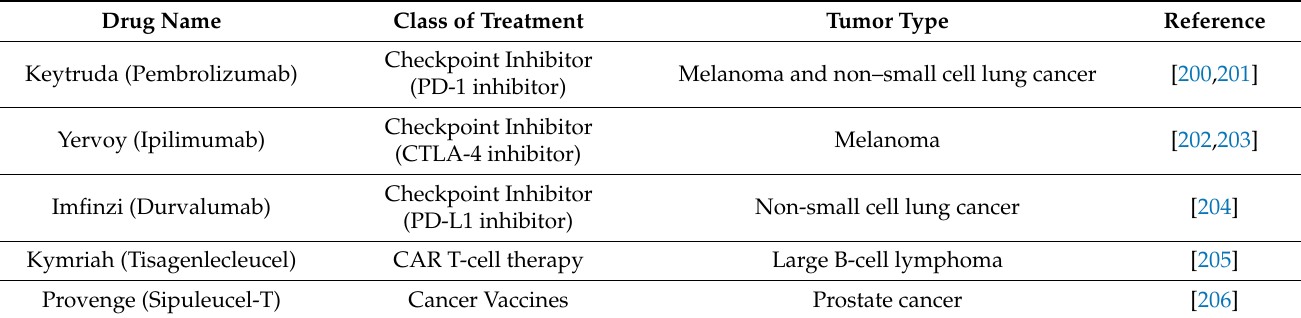
Table 3. NPs-based immunotherapy for cancer